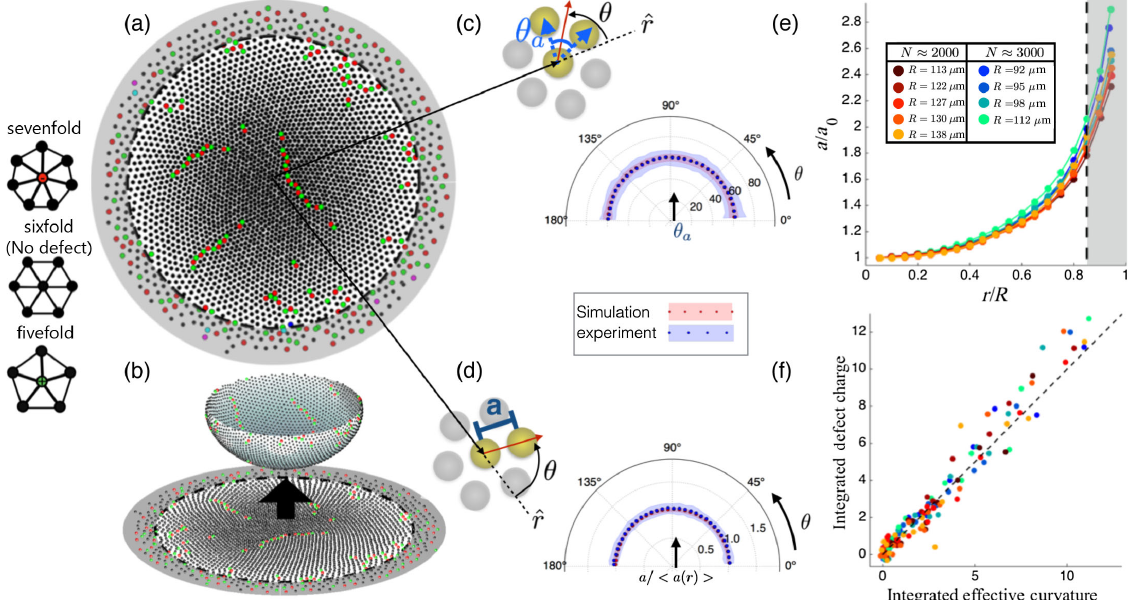
FIG. 2. Conformal geometry and defects. (a) After collecting microscope images of the equilibrated system, each particle is identified and the resulting structure is triangulated. Here, fivefold and sevenfold defects are colored green and red, respectively, while black particles are undefected. The shaded gray area represents the boundary region, which is not used for the analysis. In this region, the net defect charge drops to þ 6 , as demanded by topological constraints. (b) Conformal transformation between inhomogeneous and homogeneous structures. Above the flat, experimental structure is the corresponding transformed, curved crystal. (c) Average angle between bonds vs orientation of bisect. The angle between adjacent bonds is plotted against the orientation of the bisect of those two bonds with respect to the radial direction. We find that the angle of bonds is the value expected for a triangular lattice, irrespective of the orientation. In other words, adjacent bonds that are oriented in the azimuthal direction and those oriented in the radial direction both are separated by 60 degrees. (d) Average bond length vs orientation of bond. The length of bonds, normalized by the average local lattice spacing at that distance from the structure ’ s center, is plotted against the orientation with respect to the radial direction. We find that bond lengths are uniform, irrespective of their orientation. (e) Lattice spacing plotted against radial position in the crystal. Two sets of experiments are shown, each with a different number of particles. Each color represents a different experimental run. By changing the confinement strength, the resulting crystal sizes, R , are varied. (f) Integrated defect charge vs integrated effective curvature. The effective integrated curvature is plotted against the net defect charge for varying positions within the resulting structures. The colors shown correspond to those in (e). The dotted line represents a line with slope